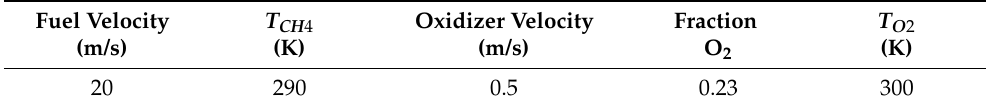
Table 3. The boundary conditions.